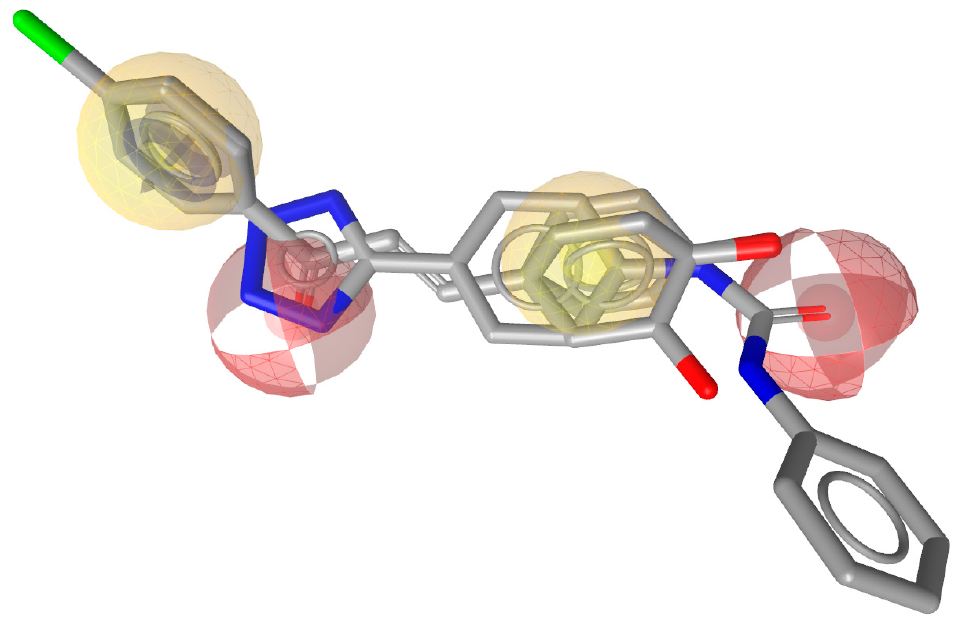
Figure 1. Pharmacophore model geometry and its five features. Yellow represents hydrophobic, blue refers to the aromatic ring, and red denotes the hydrogen bond acceptor feature.